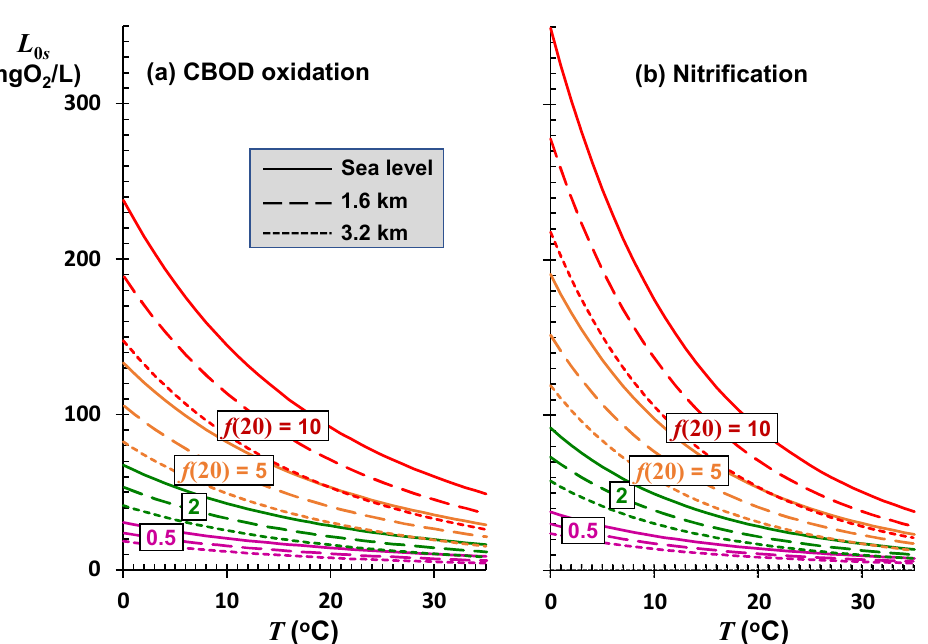
Figure 8. Plot of the mixing-point concentration versus temperature for freshwater rivers at several elevations and self-purification constants.